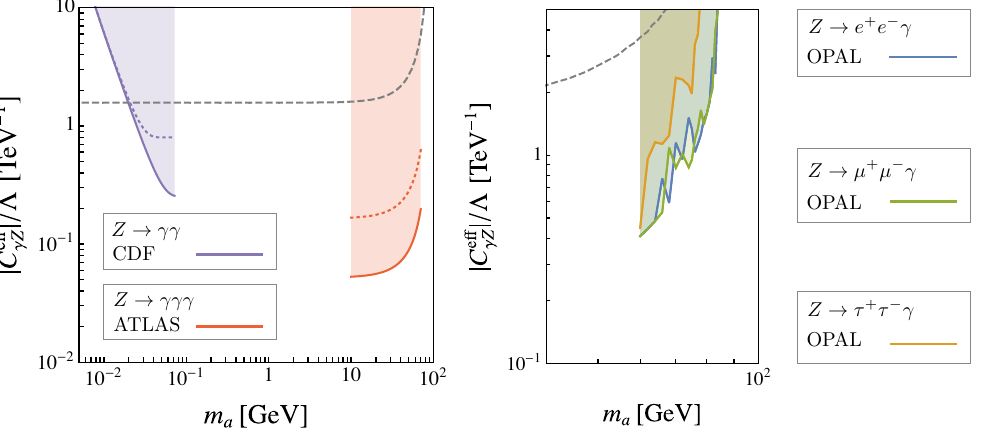
Figure 22 . Parameter space excluded by measurements of Br( Z measurements of Br( Z by solid lines assume Br( a The gray dashed line is the bound from